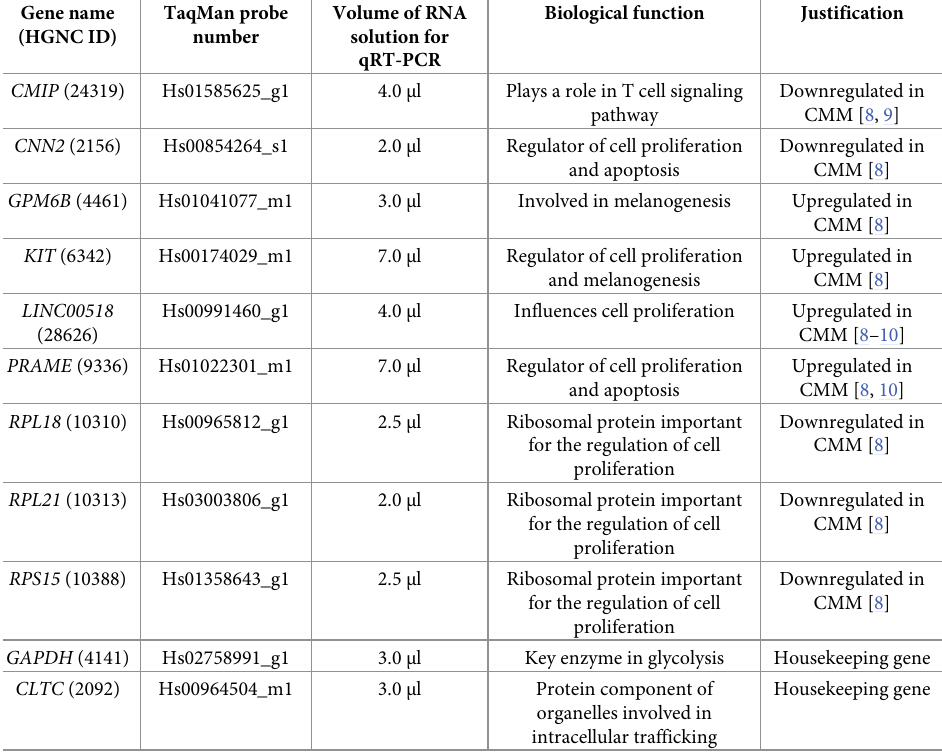
Table 2. List of the 11 genes to be tested in the present study with procedures and justifications for testing